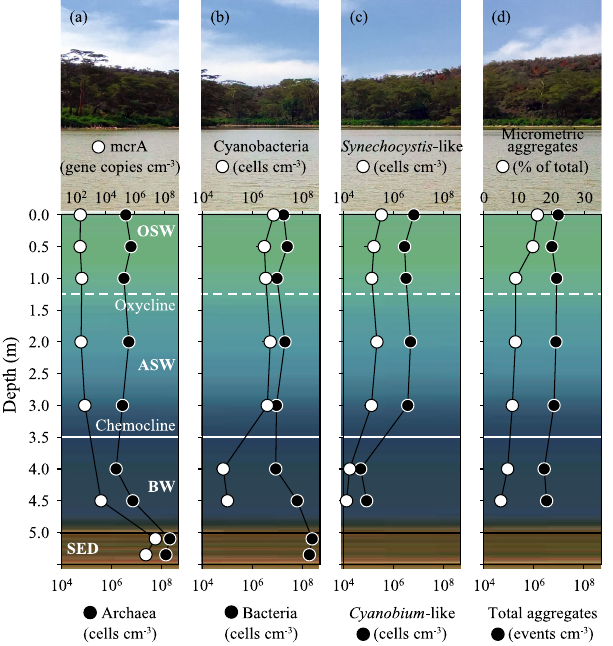
Fig. 5 Vertical pro fi les of microbial community across the water column. a Abundance of Archaea and mcrA gene copies. b Abundance of Bacteria and Cyanobacteria. c Abundance of Cyanobium -like and Synechocystis -like cells. d Concentration of total aggregates and percentage of micrometric aggregates (>1 μ m). Error bars for the microscopy observations ( n = 3) are within the size of the